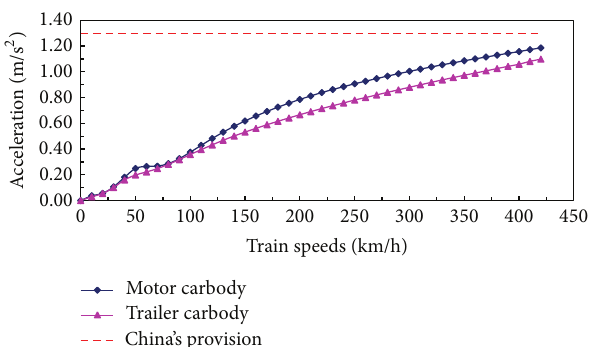
Figure 26: Maximum carbody vertical acceleration under various train speeds.